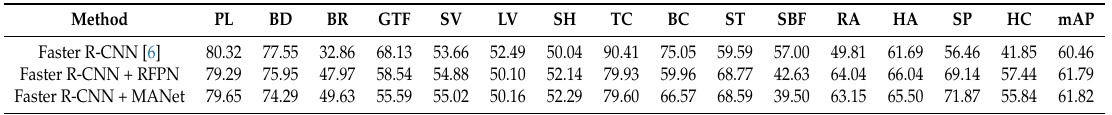
Table 6. The efficientiveness of RFPN and MANet on Faster R-CNN. The short names here are the same as that in Table 2.